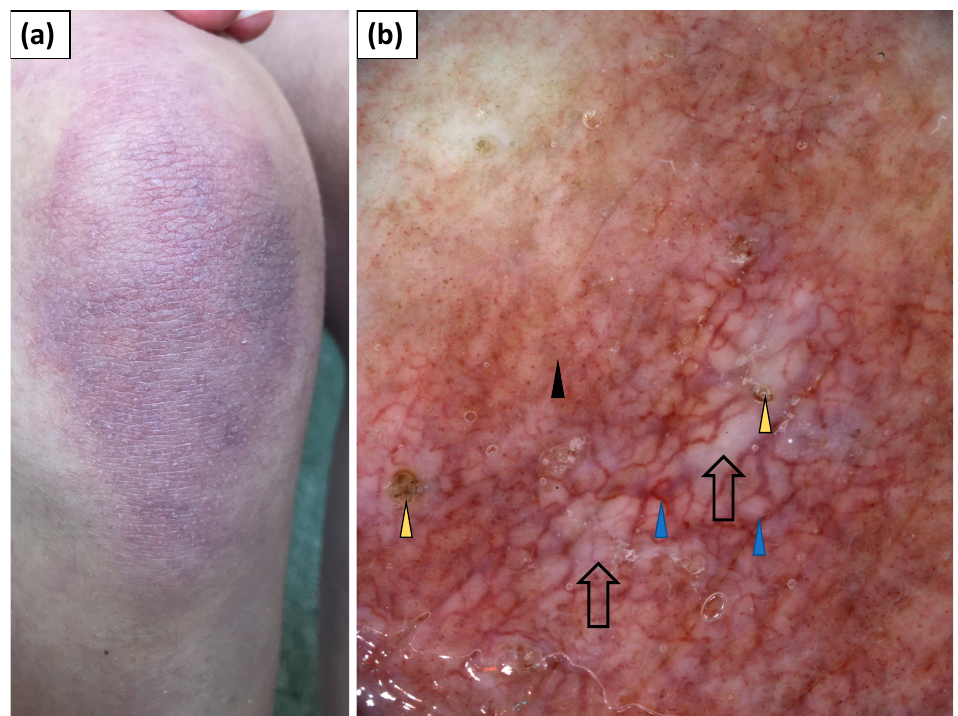
Figure 4. ( a ) Clinical presentation of Gottron’s sign over the elbow. ( b ) Videodermoscopy of Got- tron’s sign showed irregularly distributed linear vessels with branches (blue arrowhead) and white structureless areas (black arrow).